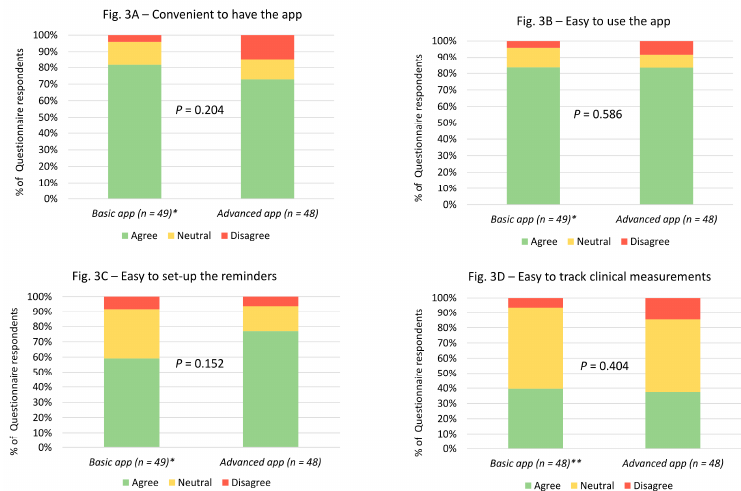
Figure 3. Acceptability-related questionnaire responses in both basic and advanced app groups. *1 missing response in the basic medication reminder app group. **2 missing responses in the basic medication reminder app group.